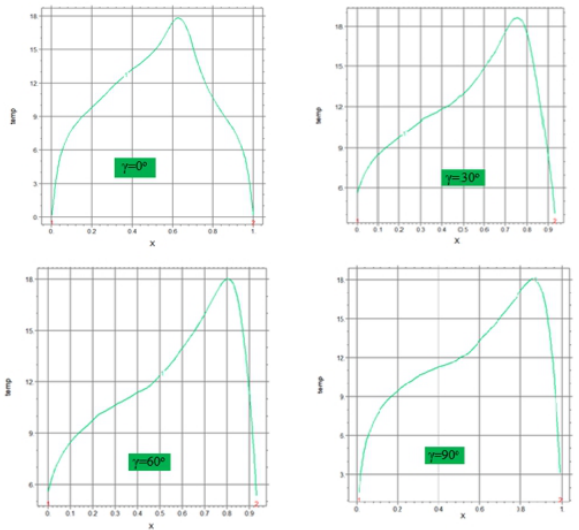
Fig. 8. Variation of local temperature along heated surface, Ra = 10 6 , Ω = 500, and C = 0.1